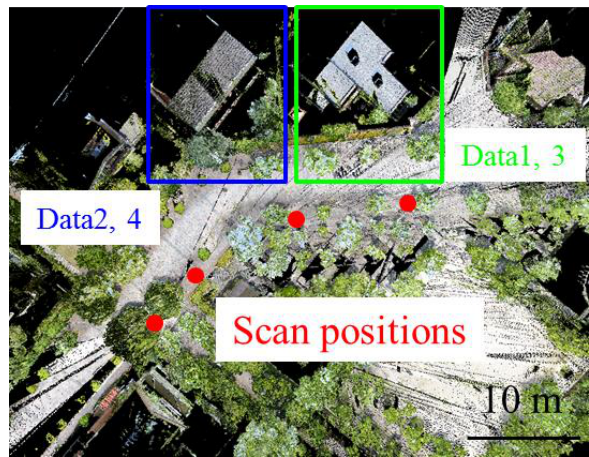
Figure 1. Test site. The red dots represent four scan positions and the rectangles show the areas of data.